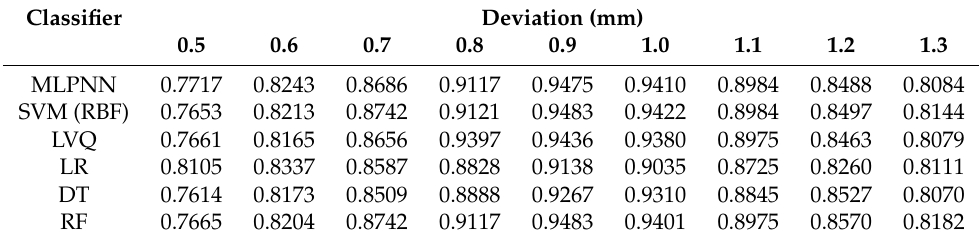
Table 1. Classification accuracy at different LB deviations from the joint center line.